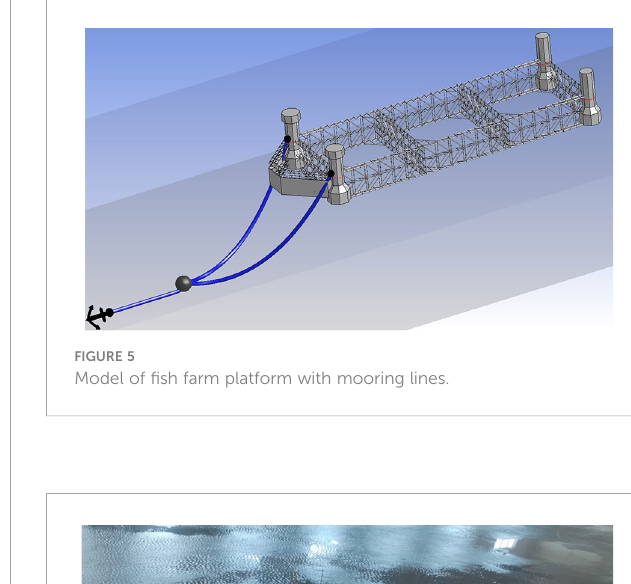
FIGURE 5 Model of fi sh farm platform with mooring lines.